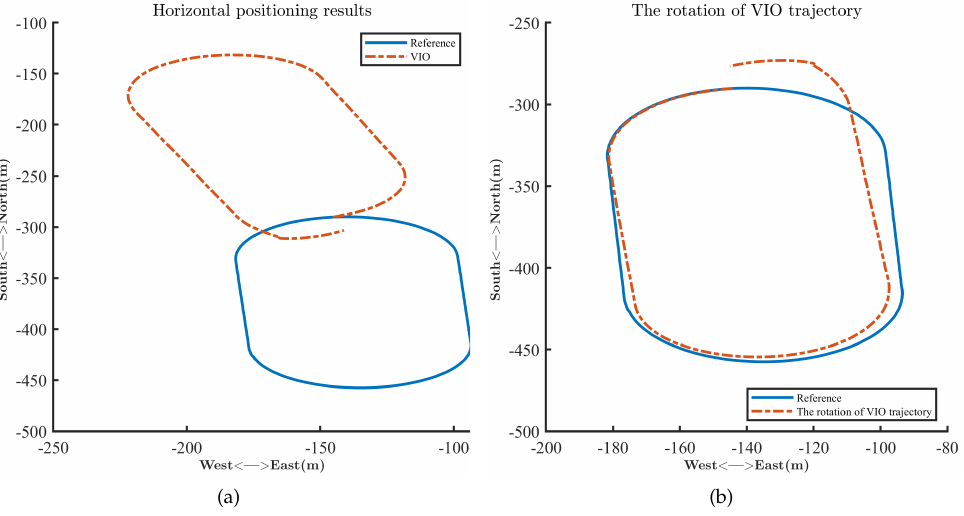
Figure 13. The performance of the standalone visual–inertial odometry (VIO). ( a ) The trajectory given by the standalone VIO. ( b ) The rotation of VIO’s trajectory. Table 5. The average difference between the first and final position of the VIO and RTK trajectories.